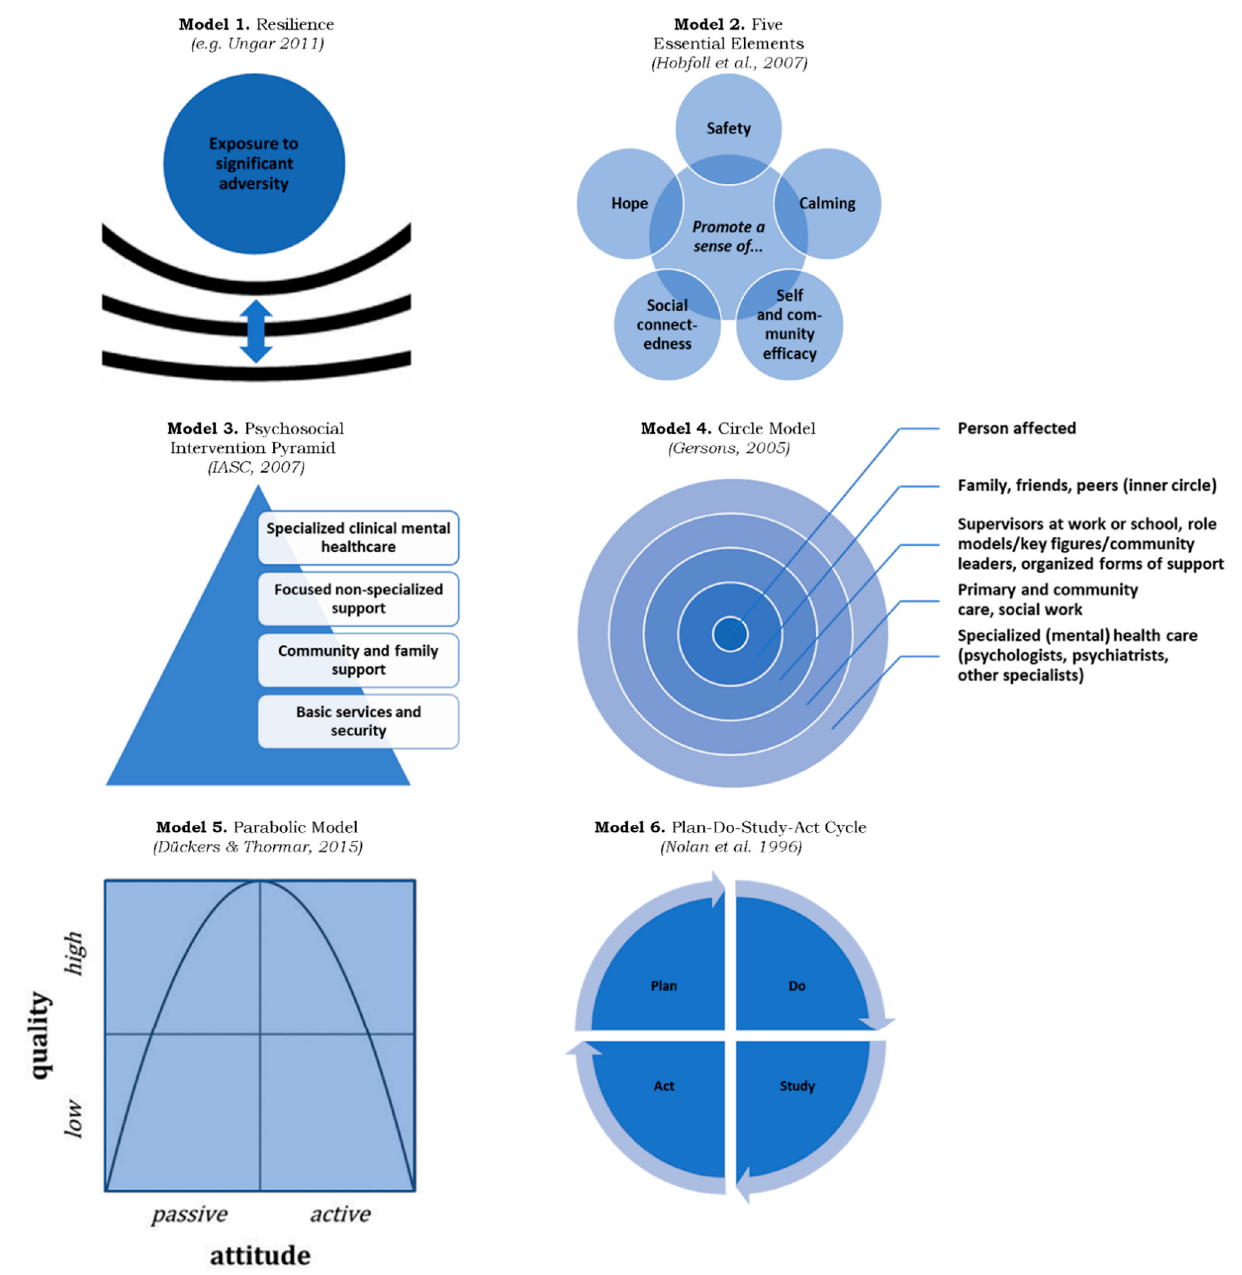
Figure 2. Six Models (Ungar 2011 [51], Hobfoll et al. 2007 [52], IASC 2007 [17], Gersons 2005 [55], Dückers & Thormar 2015 [47], Nolan et al. 1996 [56]).